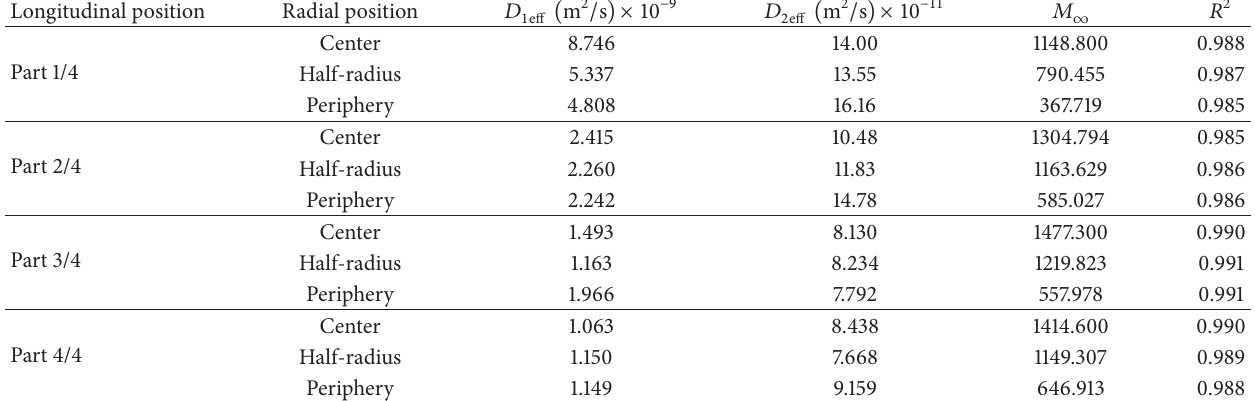
Table 6: Effective diffusion coefficient of water of the pith of Raffia vinifera during the initial and final stage. Longitudinal